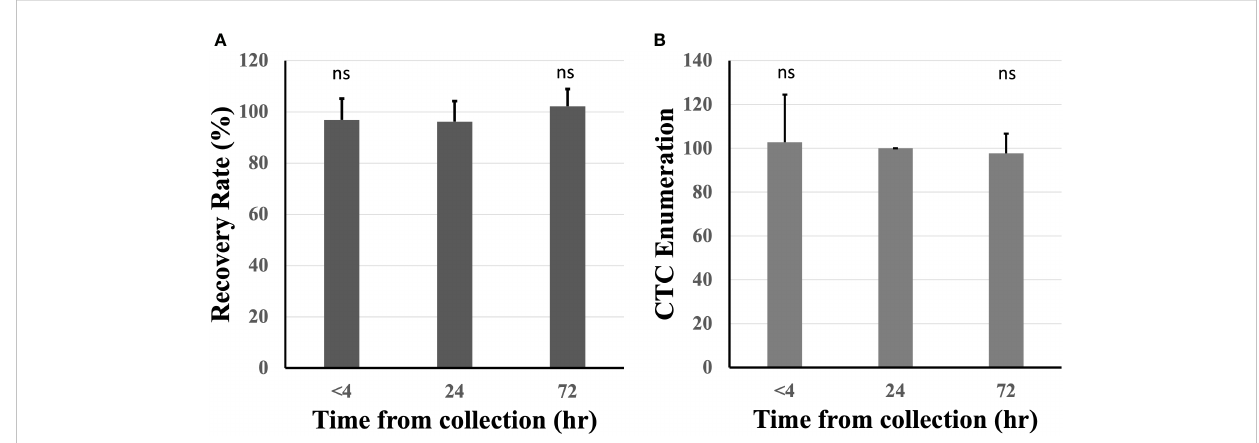
FIGURE 3 Recovery rates were maintained across different blood incubation times. Recovery rates were similar when compared at time of collection (<4 hours), 24 and 72 hours in healthy spiked-in blood (A) . Similar CTC enumerations were found at different incubation times in 4 subjects diagnosed with cancer (CTC counts normalized to 24 hours) (B) . n.s, not signi fi